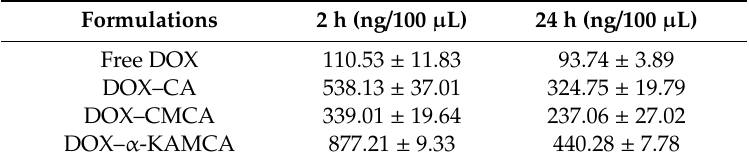
Table 1. Estimation of serum drug concentration following an intravenous injection of free doxorubicin (DOX), DOX-loaded carbonate apatite (CA) nanoparticles (NPs), DOX-loaded citrate-modified CA (CMCA) NPs, and DOX-loaded α -ketoglutaric acid-modified CA ( α -KAMCA) NPs ( n = 5).